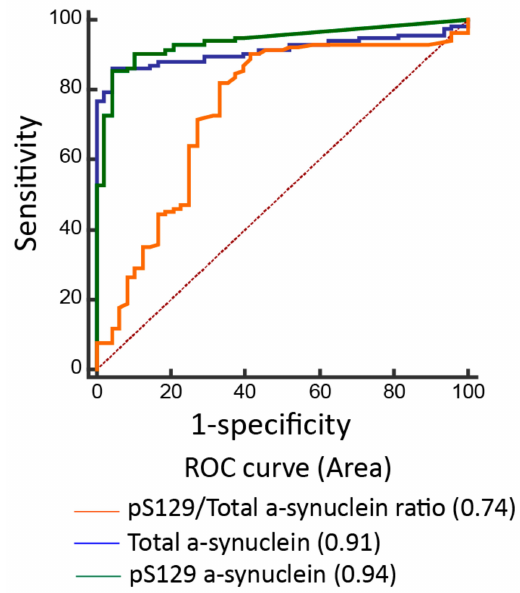
Figure 2. Receiver operating characteristic curves for predicting disease in participants. The accuracy of predicting Parkinson’s disease using the pS129/total α -synuclein ratio (area under curve (AUC) = 0.63), total α -synuclein level (AUC = 0.91), and pS129- α -synuclein (AUC = 0.94).